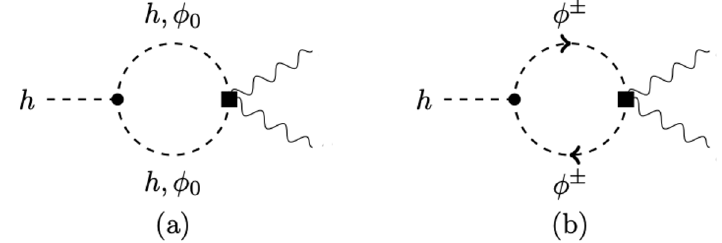
Figure 2 . One loop contributions to h φ 4 | F F ih δM AB